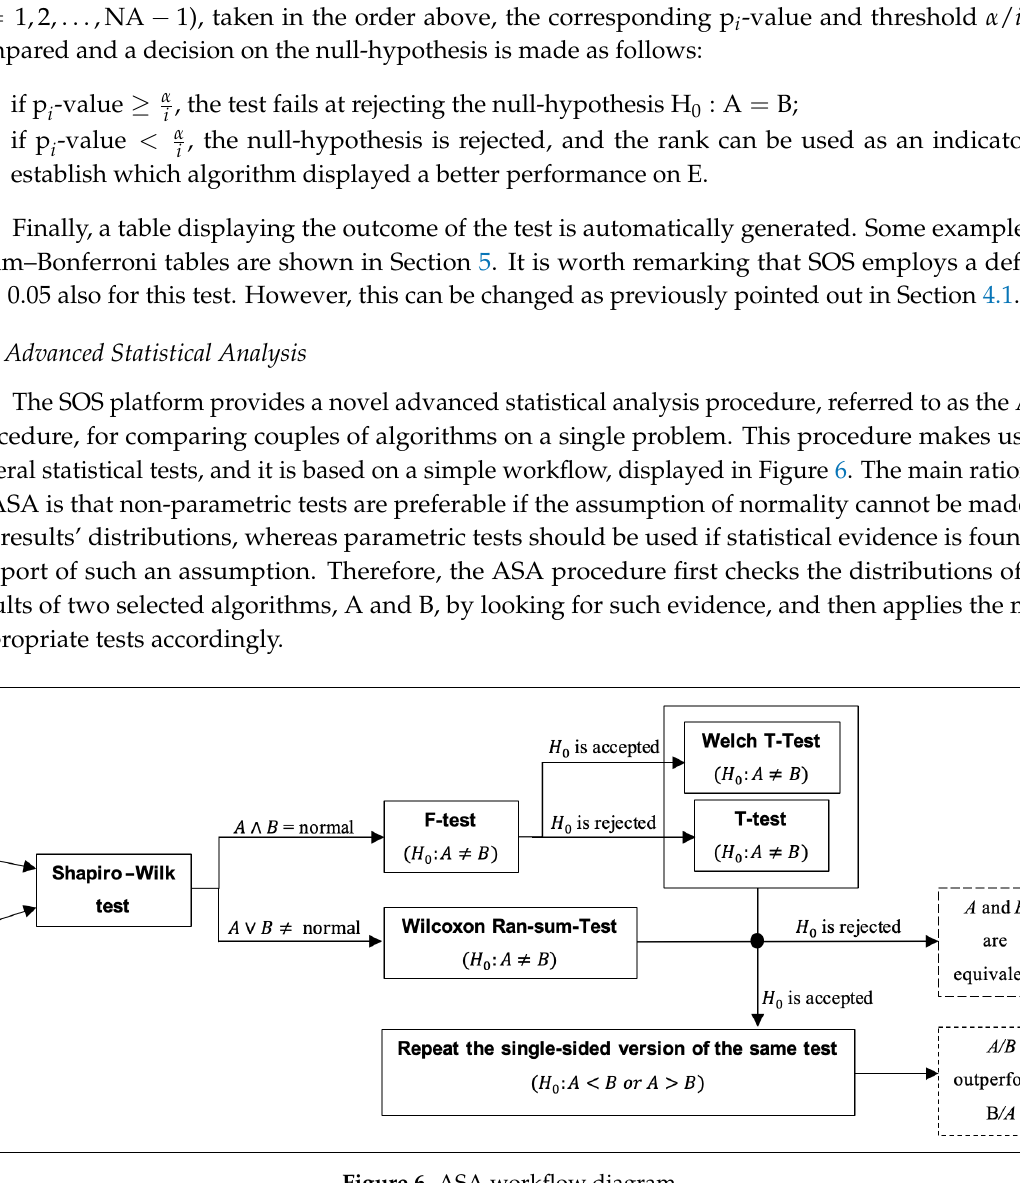
Figure 6. ASA workflow